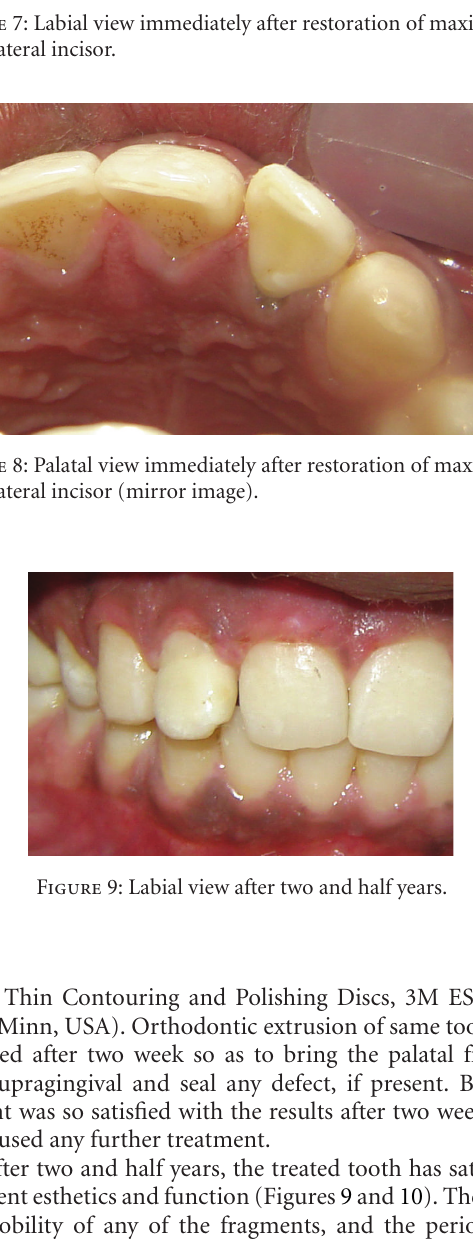
Extra Thin Contouring and Polishing Discs, 3M ESPE,